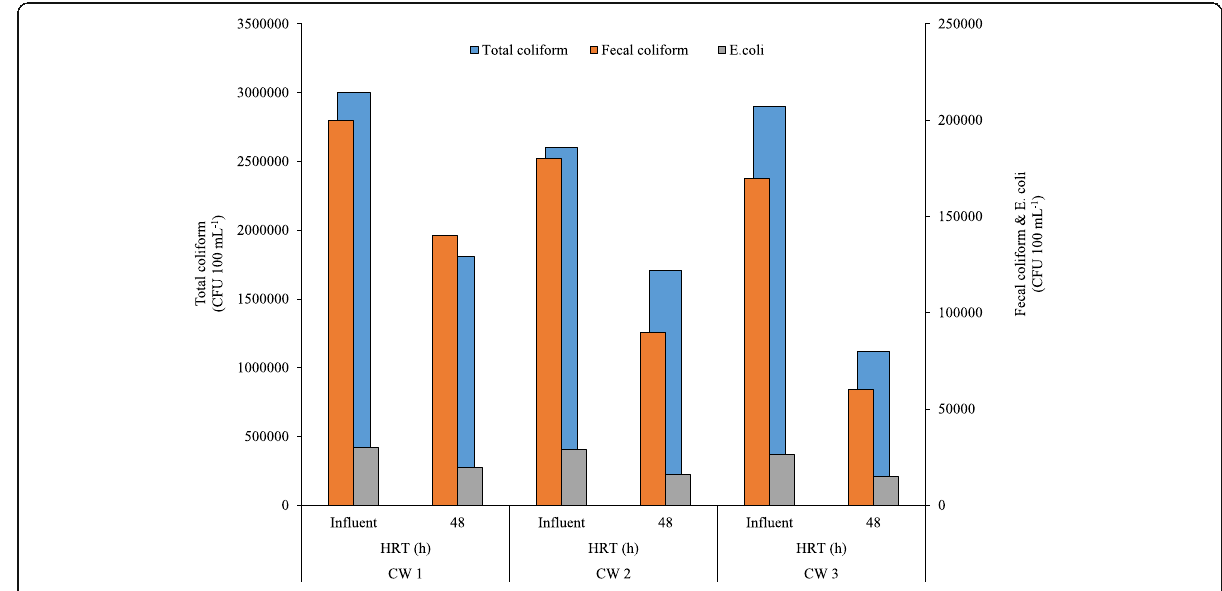
Fig. 4 Variation in coliform (Total, Fecal and E. coli) of primary treated sewage through the constructed